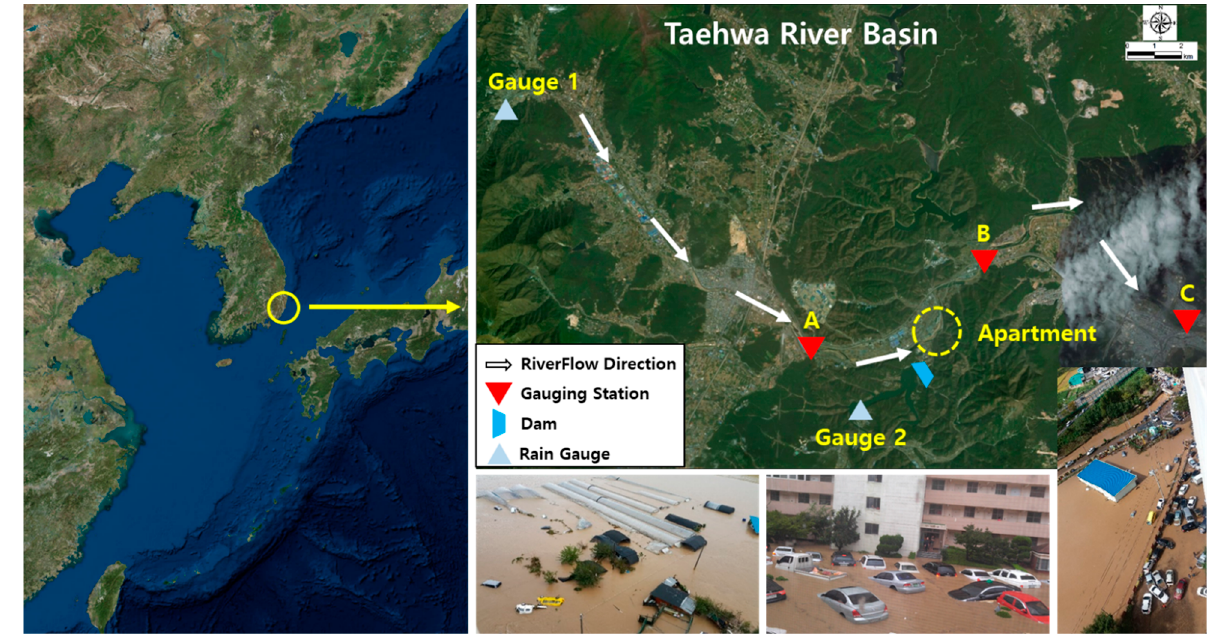
Figure 5. Study area and damage photos.